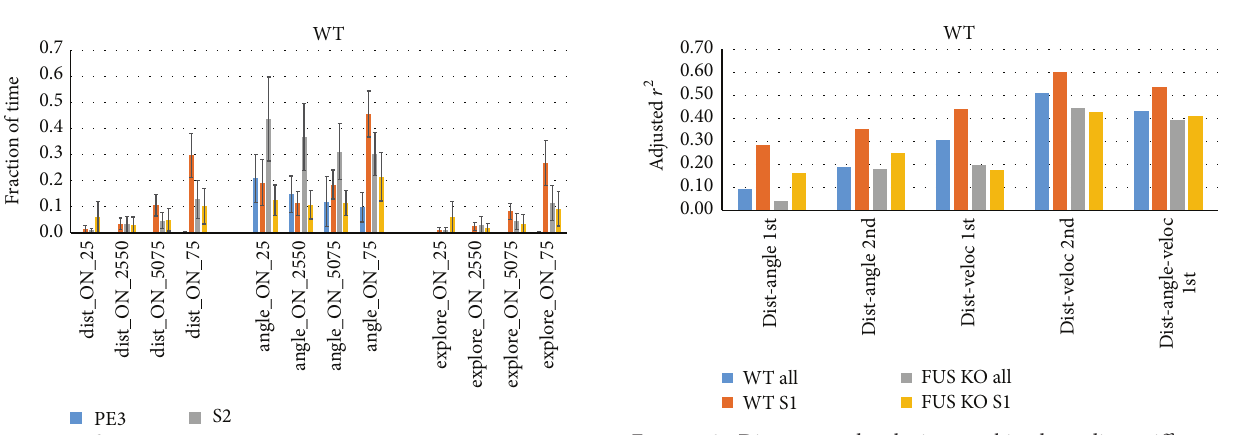
Figure 8: Distance and velocity combined predict sniff rates. Population vectors that include all time bins from all WT mice were used to regress both nose to odor source distance and head angle to odor source (dist-angle) or distance and velocity (dist-veloc) parametrically onto sniff rates using 1st- or 2nd-order equations (shown in Figure 9), for either all trials of WT or FUS KO mice or their S1 trials. The 2nd-order distance-velocity regression explained 43–60% of sniff rates (adjusted 𝑟 2 ; S1: 𝑛 = 7 mice ∗ 1201 time bins = 8407 bins; all: 𝑛 = 7 mice ∗ 1201 bins ∗ 4 trials = 33,628 time bins). A 3-way stepwise 1st-order multiple regression (dist-angle-veloc 1st, right) also robustly explained sniff